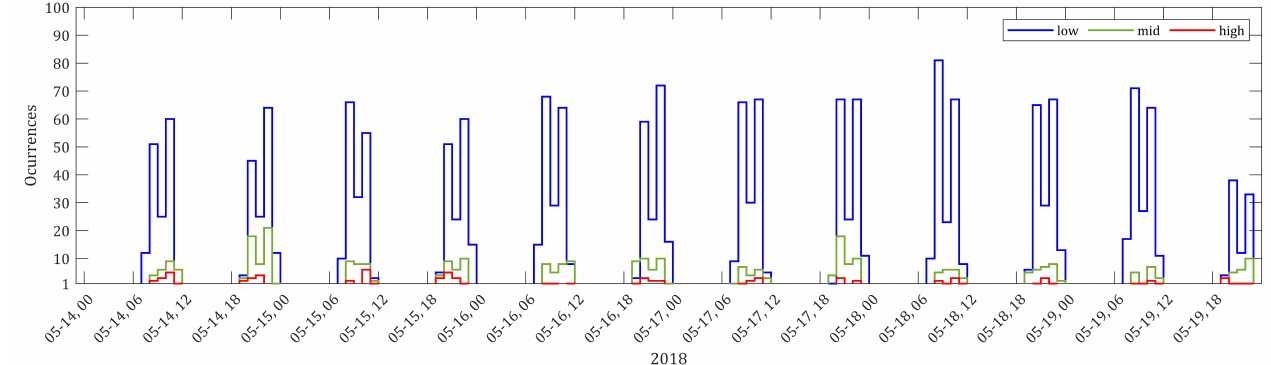
Figure 7. Local time distribution of S 4 index on MetOp-A,B occultations during the second period with low solar activity, i.e., 14 May (DOY 134) to 19 May (DOY 139) in 2018. “Low” corresponds to S 4 ≤ 0.2, “Mid” to 0.2 < S 4 ≤ 0.5 and “High” to S 4 > 0.5. The occurrence of strong scintillations is lower than in the period evaluated in